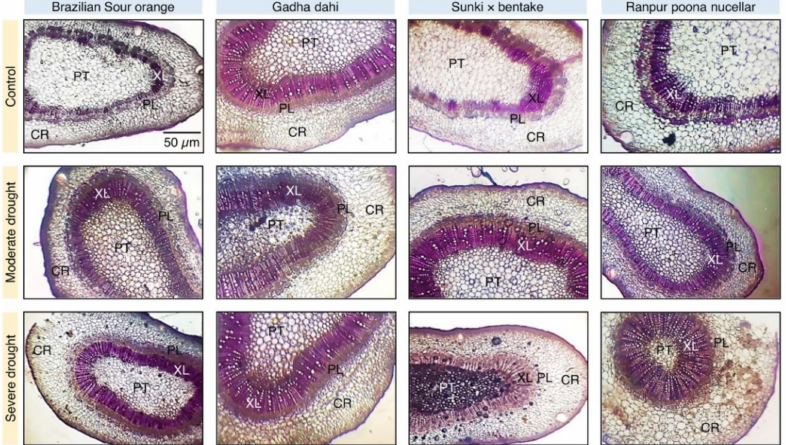
Figure 3. Stem transverse section of two highly tolerant (Brazilian sour orange and Gadha dahi) and two highly sensitive genotypes (Rangpur Poona nucellar and Sunki × bentake). PT: pith; CR: cortex; XL: xylem; PL: